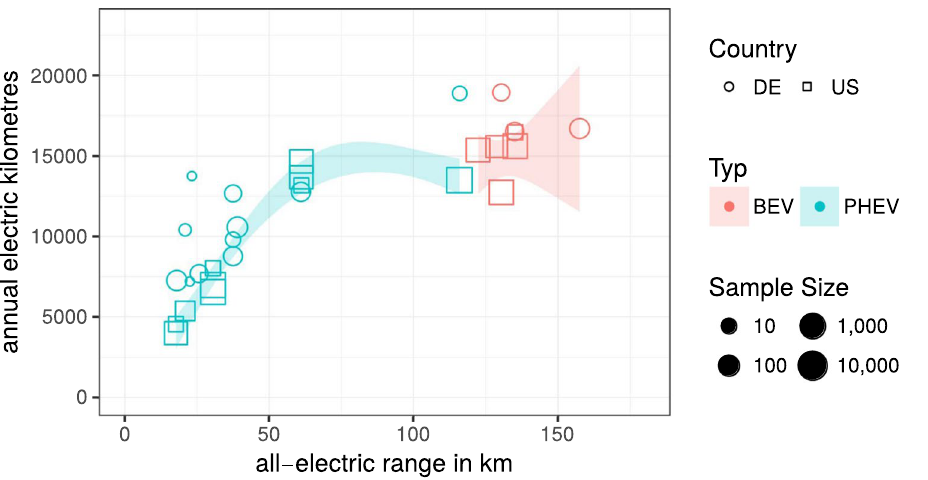
Figure 2. Average electrified annual kilometres for different PHEV (green) and BEV (red) models from the US (squares) and Germany (circles). The shaded areas are sample size weighted local smoothers (95% confidence